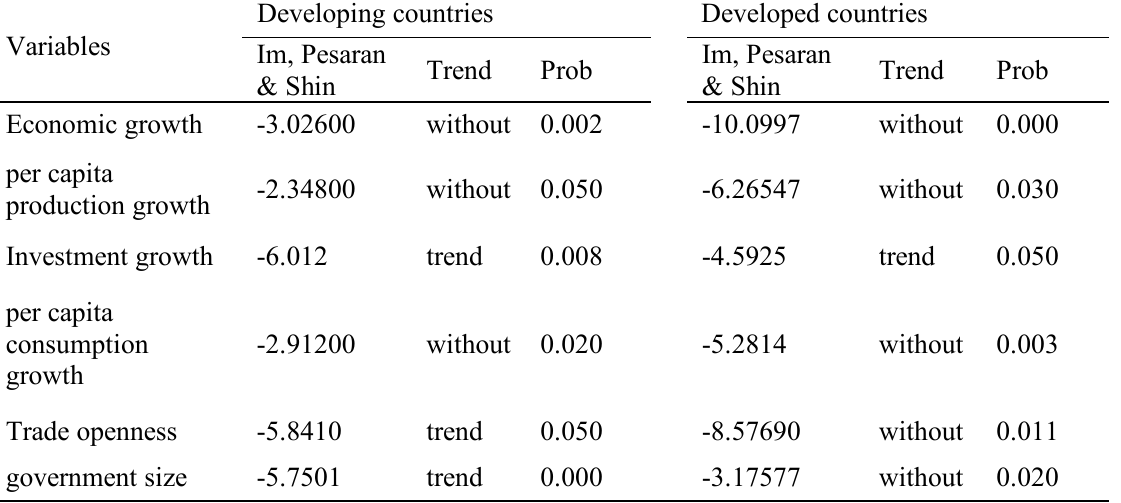
Table 1 . Results of unit root tests of model variables in two groups of countries